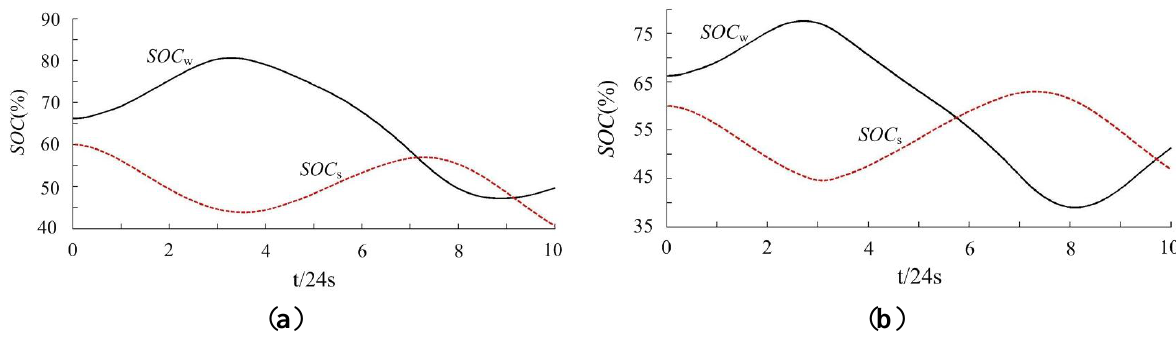
Figure 9. SOC w and SOC s of energy storage systems under different sharing strategies of load power. ( a ) Average allocation of load power; ( b ) Coordinated allocation of load power.